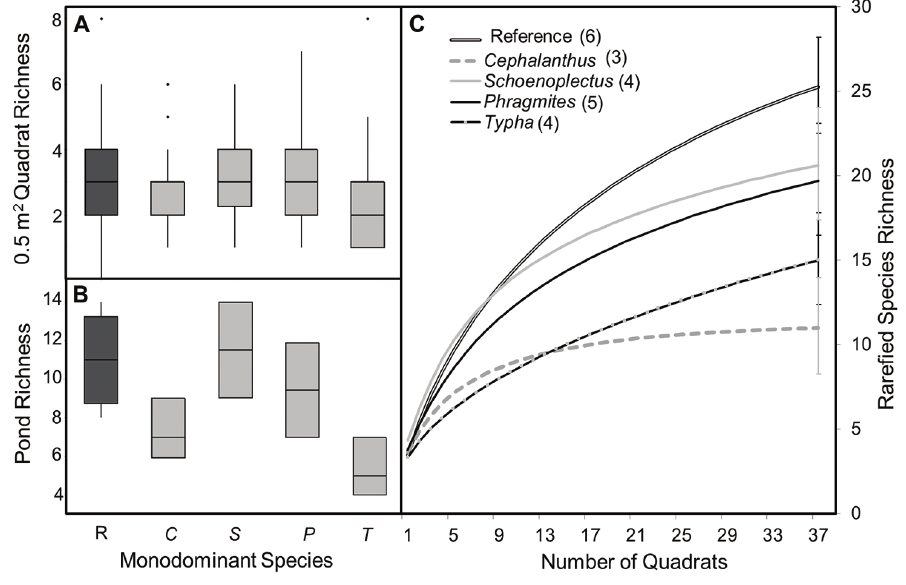
Figure 5. Richness at three scales in patches dominated by Cephalanthus occidentalis (C), Schoenoplectus acutus (S), Typha × glauca (T), Phragmites australis (P) or reference areas (R). A 0.5 m 2 quadrats B ag- gregated pond-level richness (12 quadrats) C Mao-Tau sampling-richness relationships, with the number of ponds each type was sampled in indicated in parentheses. Error bars indicate standard deviation at 37 quadrats. Patch type (monodominant species) was a significant predictor of pond-level richness as evalu- ated via a mixed-model ANOVA (F = 3.81, p = 0.035, model R 2 =